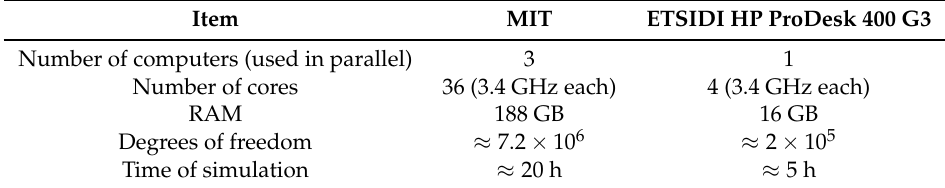
Table 1. Computers used for streamer simulation in oil transformers at Massachusetts Institute